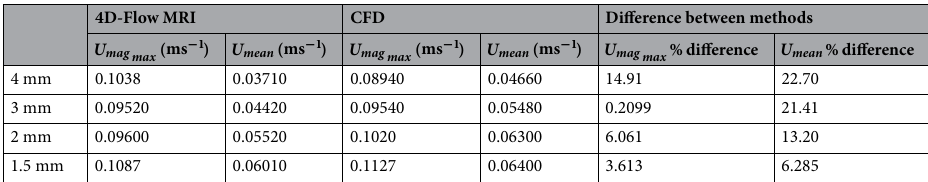
Figure 6. Averaged systolic and diastolic velocity magnitude ( ms − ascending aorta, comparing 4D-Flow MRI and CFD for all spatial